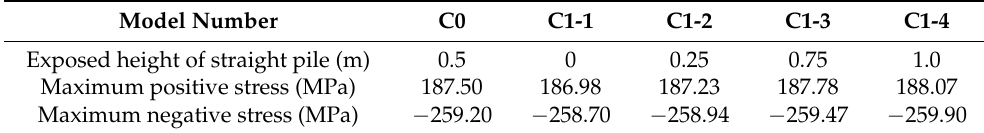
Table 9. Model C1 parameter